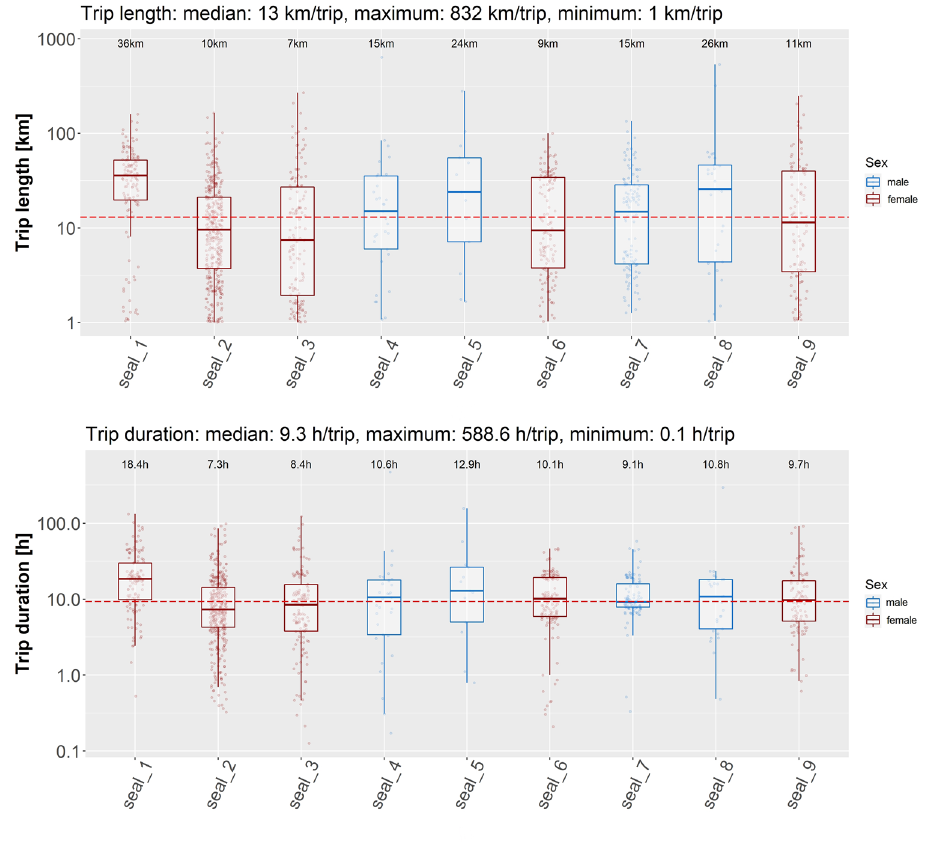
Figure 7. Length (top) and duration (bottom) of trips for each individual coloured by sex. The data values shown on the y-axis were log transformed to account for outliers present in the data. Median values of each individual are given at the upper end of each boxplot. Overall maximum and minimum values are shown in the plot title. Boxes represent the 25th and 75th percentiles, the bar the median and whiskers extend from the hinge to the largest or smallest value but no further than 1.5 * the inter-quartile range. The x-axis shows the seal